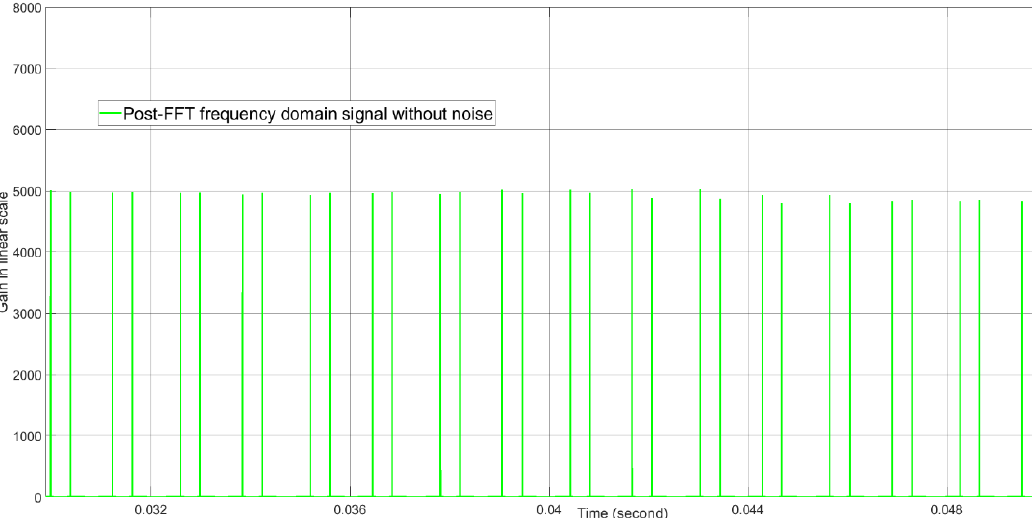
Figure 12. The post-FFT desired tone energy without noise when initial Doppler is equal to the true Doppler at about 0.04 s real time. This result is generated by computer simulation, not by FPGA simulation.